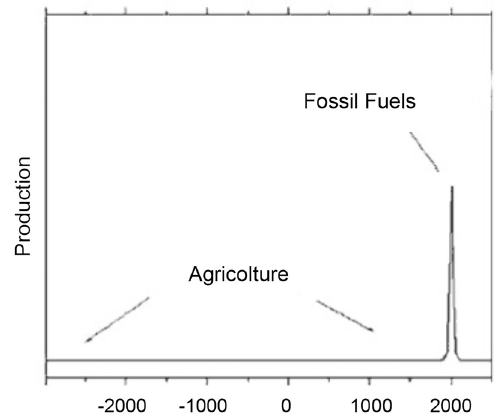
Fig. 13. – Historical mankind energy